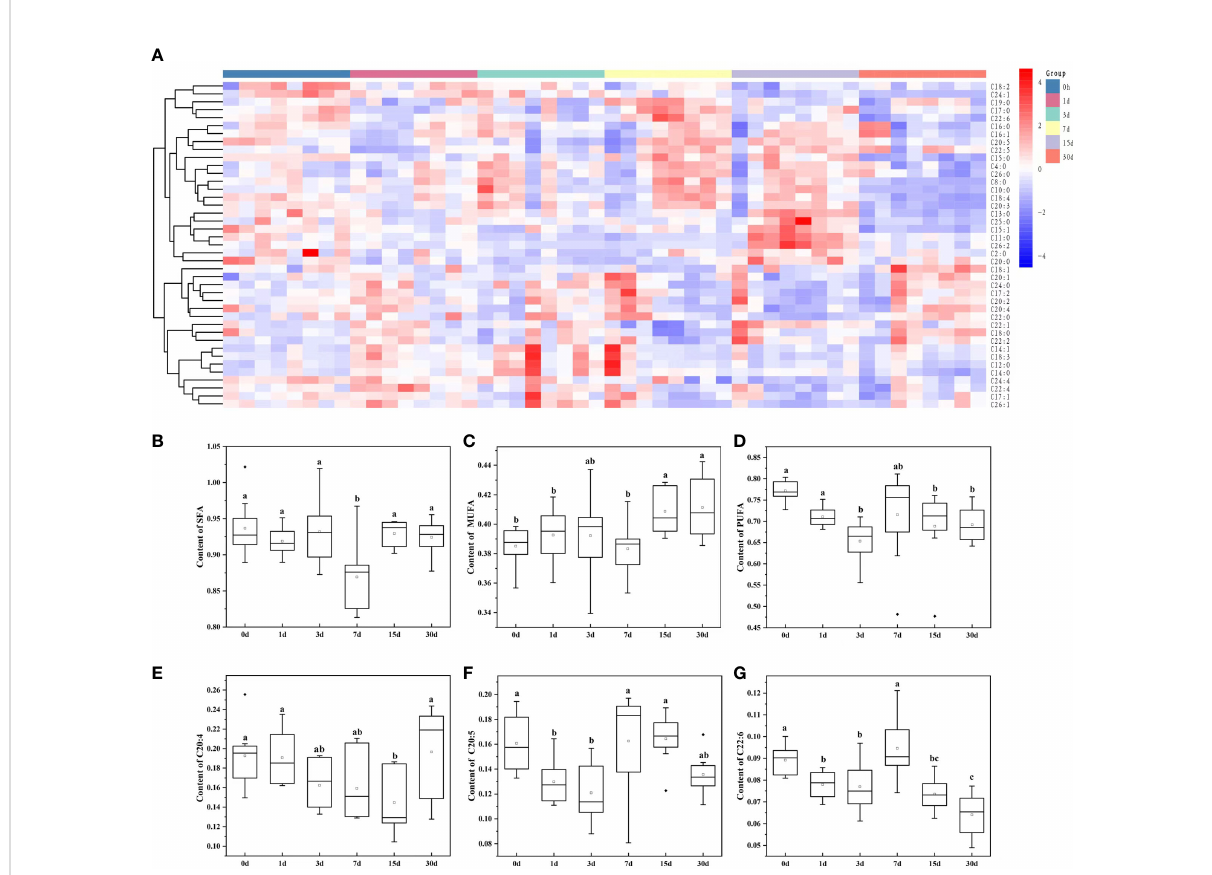
FIGURE 2 Changes in the content of membrane-esteri fi ed fatty acids in GP of transplanted pearl oyster P. f. martensii throughout different transplantation periods. (A) Heatmap analysis of 41 membrane-esteri fi ed fatty acids in GP. The relative metabolite level is depicted according to the color scale. Red and blue indicate upregulation and downregulation, respectively. (B) Changes in the content of membrane-esteri fi ed SFA in GP. (C) Changes in the content of membrane-esteri fi ed MUFA in GP. (D) Changes in the content of membrane-esteri fi ed PUFA in GP. (E) Changes in the content of membrane-esteri fi ed C20:4 in GP. (F) Changes in the content of membrane-esteri fi ed C20:5 in GP. (G) Changes in the content of membrane- esteri fi ed C22:6 in GP. Different small letters indicate signi fi cant differences between different transplantation periods (P <